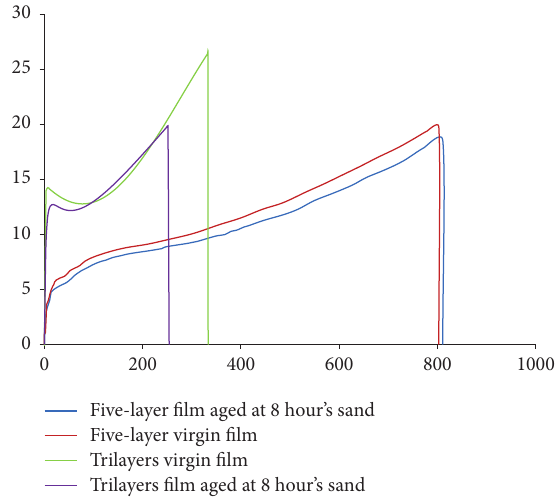
Figure4:Stress-straincurvesofvirginandaged(for8hoursbysand wind at 40 ∘ C) five-layer and trilayer films ( 𝑥 -axis: strain in [%]; 𝑦 - axis: stress in [MPa]).